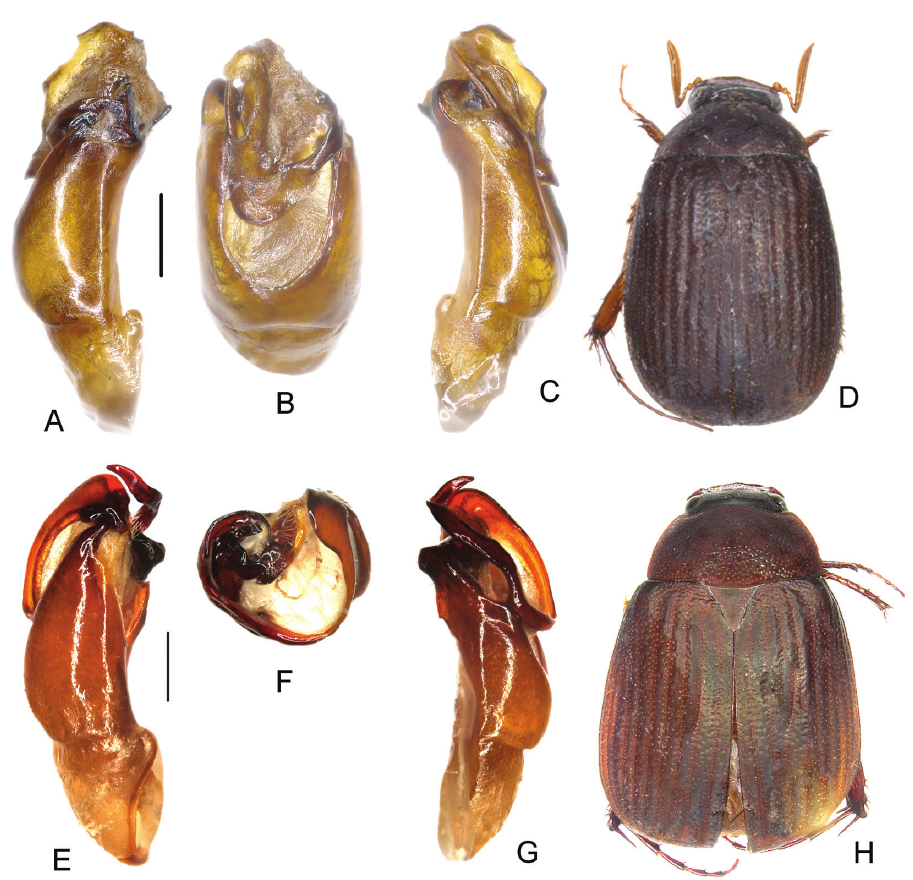
Figure 5. A–D Neoserica minor (Arrow) (China: 60km E Tengchong), E–H N. pseudosilvestris Ahrens, Fabrizi & Liu, sp. n. (holotype). A, E aedeagus, left side lateral view C, G aedeagus, right side lateral view B, F parameres, dorsal view D, H habitus. Scale bars: 0.5 mm. Habitus not to scale.